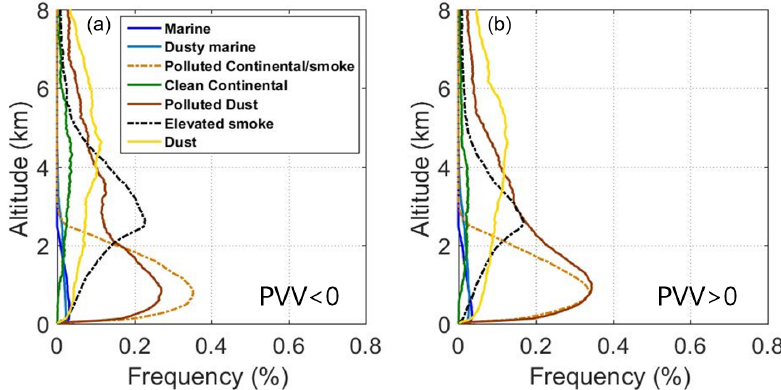
Figure 8. Vertical distributions of the nighttime FOs of different aerosol types (see legend) over the YRD, averaged over the years 2007– 2020. The profiles are stratified by pressure vertical velocity (PVV), as a measure for the strength of vertical mixing (see text), at 750hPa: i.e., for PVV < 0 (a) and for PVV > 0 (b)